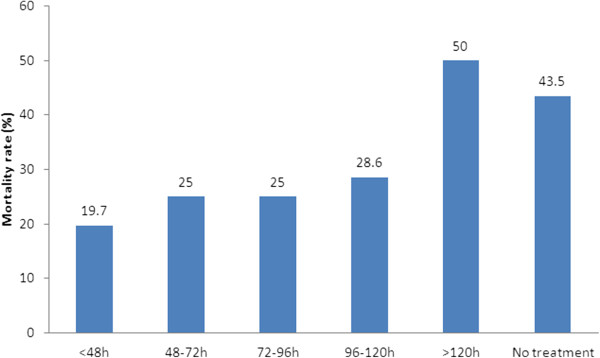
Relationship between hospital mortality (28-day) and the timing of antifungal treatment. The timing of antifungal therapy was determined to be from the time when the first blood sample for culture that was positive for fungi was drawn to the time when appropriate antifungal treatment was first administered to the patient. 28-day mortality was significantly lower for those who received appropriate empiric antifungal therapy within 120 h (5d) vs. inappropriate or delayed (>5d) empiric antifungal therapy or no antifungal treatment (20.9% vs. 45.7%, p = 0.006).